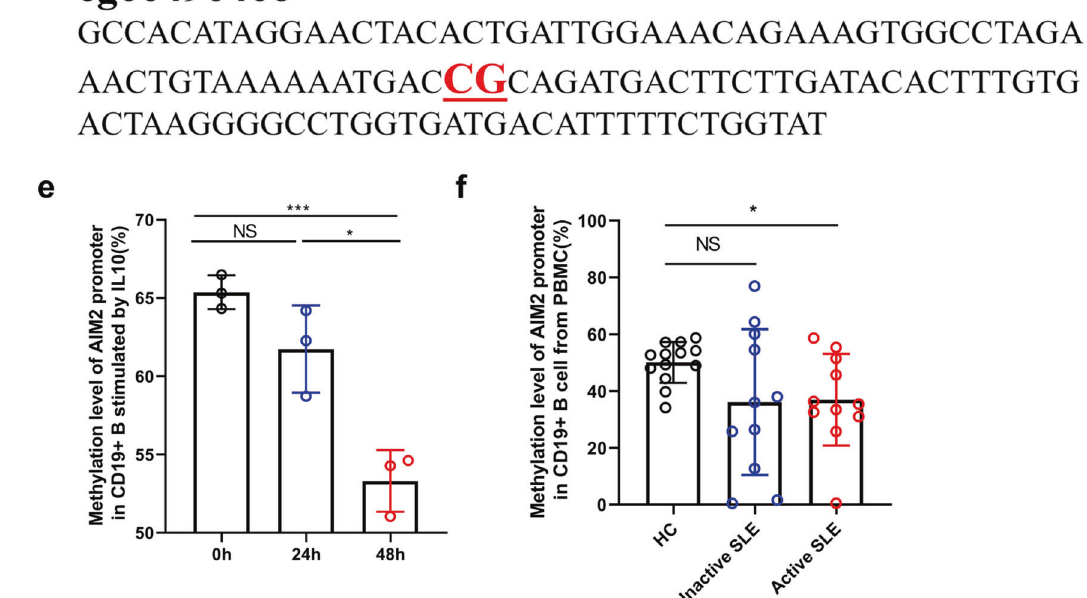
Fig. 6 IL-10 upregulates AIM2 expression via DNA demethylation. a B cells were cultured with different concentrations of IL-10 and IL-21, and the mRNA expression of AIM2 was measured by qRT-PCR. b B cells were cultured with IL-10, and the expression of AIM2 was measured by fl ow cytometry. c The serum level of IL-10 from HC subjects ( n = 24) and SLE patients ( n = 56) was detected by ELISA. d The DNA sequence for the DNA methylation-sensitive region in the AIM2 promoter. e The DNA methylation level in the AIM2 promoter after IL-10 stimulation for 24 h and 48 h. f The DNA methylation level in the AIM2 promoter in B cells of SLE patients ( n = 22) and HC subjects ( n = 13). Horizontal bars represent the mean ± SEM. * p < 0.05, *** p < level of AIM2 promoter by pyrosequencing. Using multi- AIM2, Blimp-1, and Bcl-6 in each subset of B cells. Isolating peripheral immunohistochemistry (multi-IHC) staining technique to analyze blood mononuclear cells (PBMCs) from 56 SLE patients and 70 AIM2 expression level in CD19 + B cells from SLE and DLE skin lesions healthy controls (HCs) to analyze the AIM2 expression level in B-cell subsets. Isolating CD19 + B cells from PBMCs of SLE patients and HCs and HC tonsil tissues. Serums from 56 SLE patients and 24 HCs were used to detect the level of IL-10 by ELISA. to get total genome DNA, which are used to detect the methylation